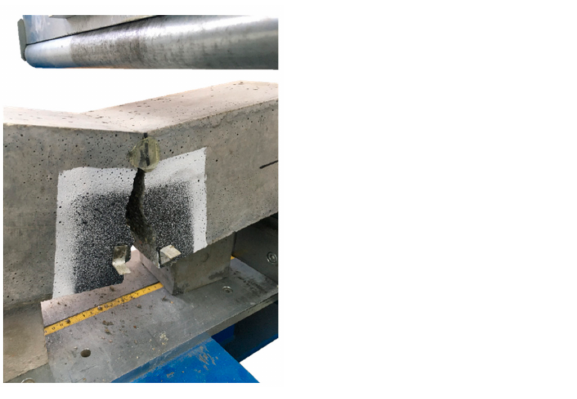
Figure 13. PC_1 beam without fibers after the three-point bending test.